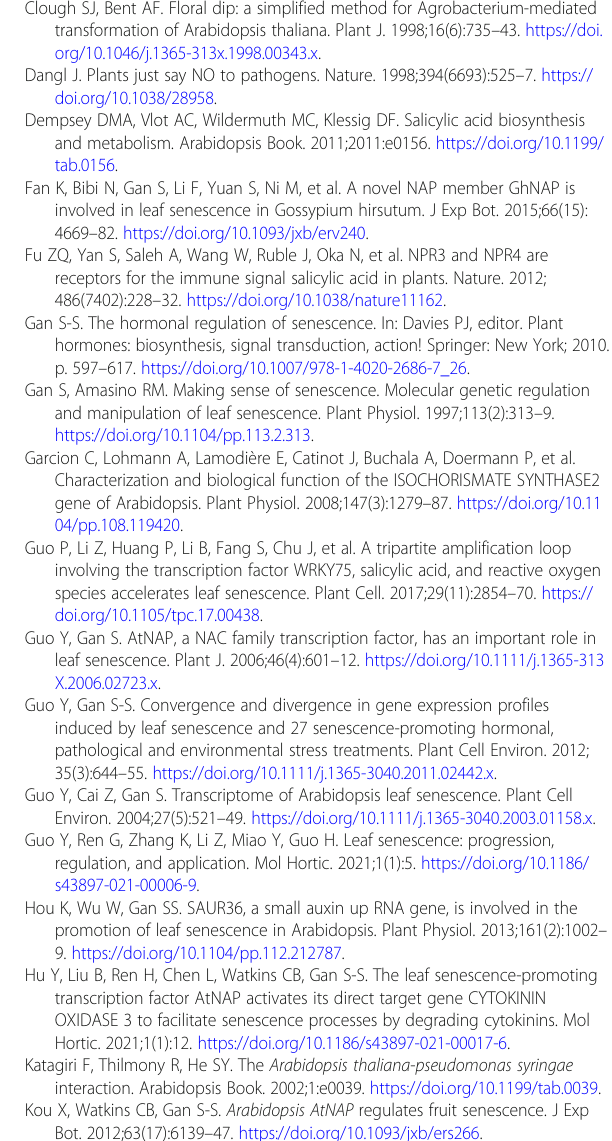
Supplementary Figure S2. qPCR analyses of transcript levels of CBP60g and ICS2 in leaves of WT, atnap, sag202 and ics1 null mutants at different senescence stages; Supplementary Table S1. Primers used in this